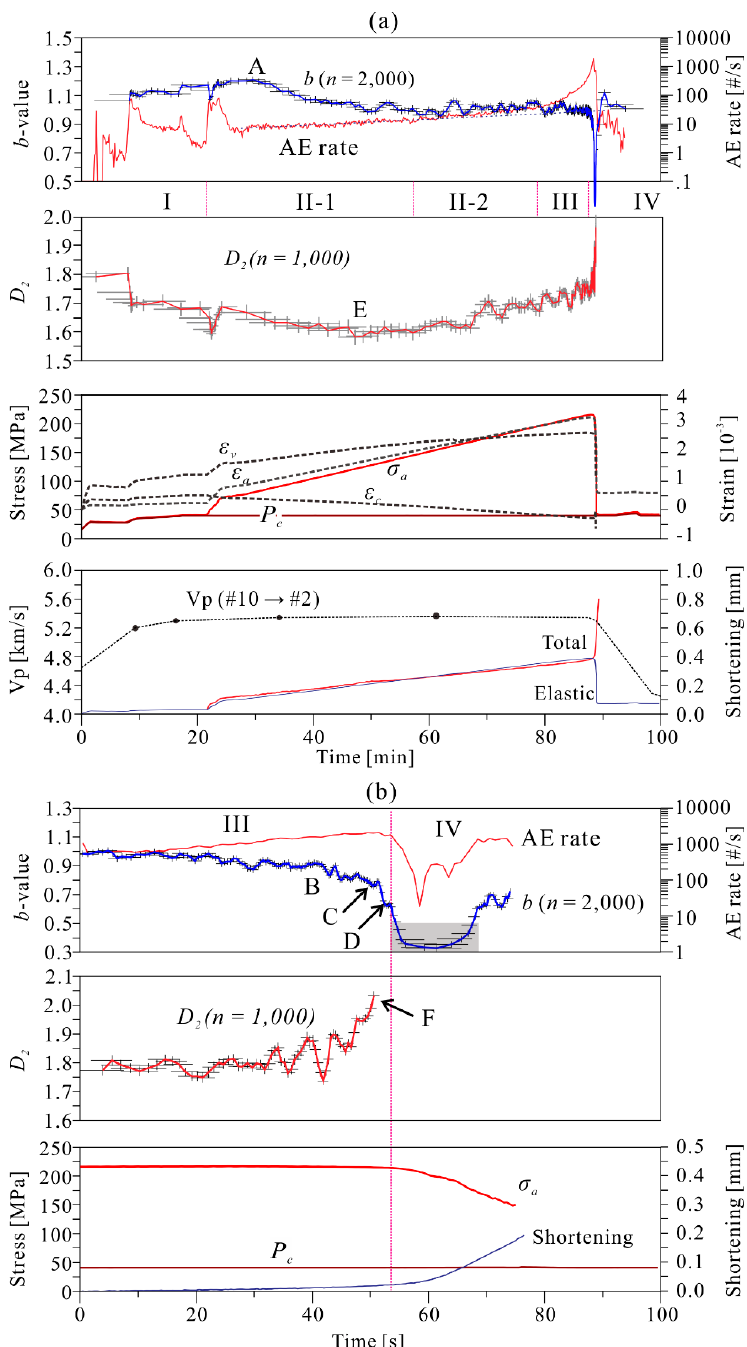
Figure 4. Plots show ( a ) key parameters with respect to time and ( b ) close-up plots of the final two stages. Acoustic emission rates were calculated for every 10 seconds. The b -values were estimated using the maximum likelihood method for a running window of n = 2,000 events with a step of 500 events. The fractal dimension ( D 2 ) was estimated for a running window and a step of n = 1,000 and 500 hypocenters. Axial, circumferential, and volumetric strains ( ε a , ε c , and ε v ) were obtained as the average of data recorded by seven pairs of stain gauges adhered directly to the surface of the specimen. The axial shortening of the specimen was estimated based on piston displacement and was calibrated using the elastic portion of the mean axial strain, ε a . The shaded period in (b) corresponds to the dynamic rupture stage, in which AE occurred at a very high rate and several events could not be separated, and thus the estimated b -values were inaccurate.